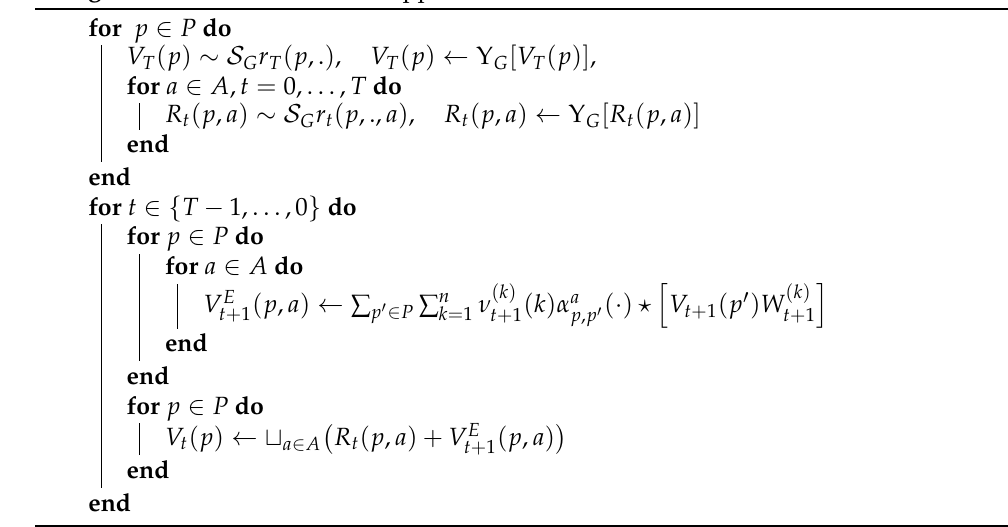
Algorithm 1: Value Function